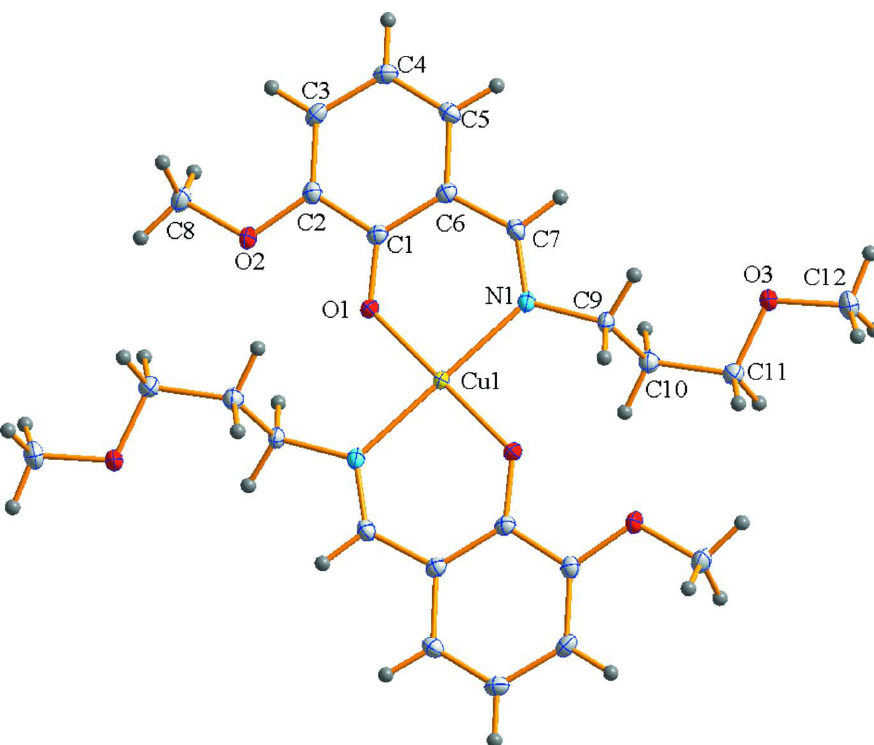
Figure 1 The structure of the title complex, showing 50% displacement ellipsoids for non-H atoms. The H atoms are dipicted by circles of an arbitrary radius. The unlabelled atoms are related to the labelled ones by - x , 1 - y , 1 - z